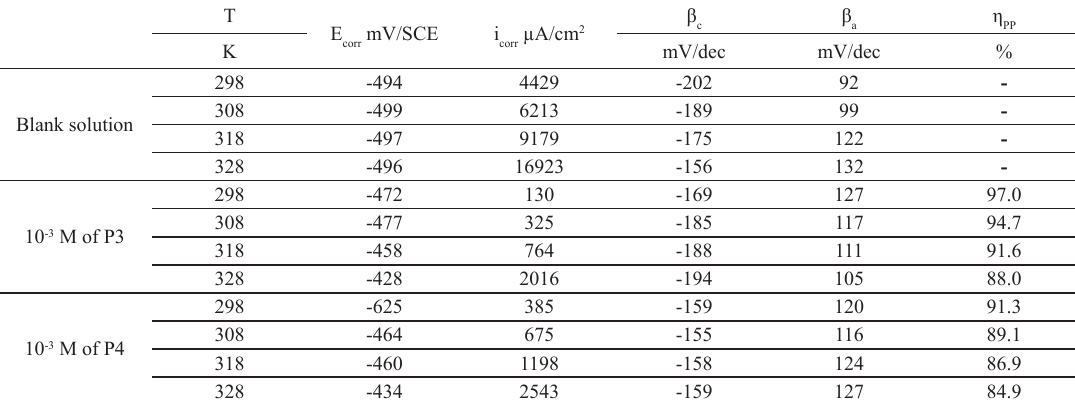
Figure 6. Potentiodynamic polarization curves for ordinary mild steel in 5.0 M HCl with the presence of 10-3 M of (a) P3 or (b) P4 at different temperatures Table 4. Electrochemical parameters and inhibition efficiency values obtained for ordinary steel in 5.0 M HCl without and with 10 -3 M of P3 and P4.